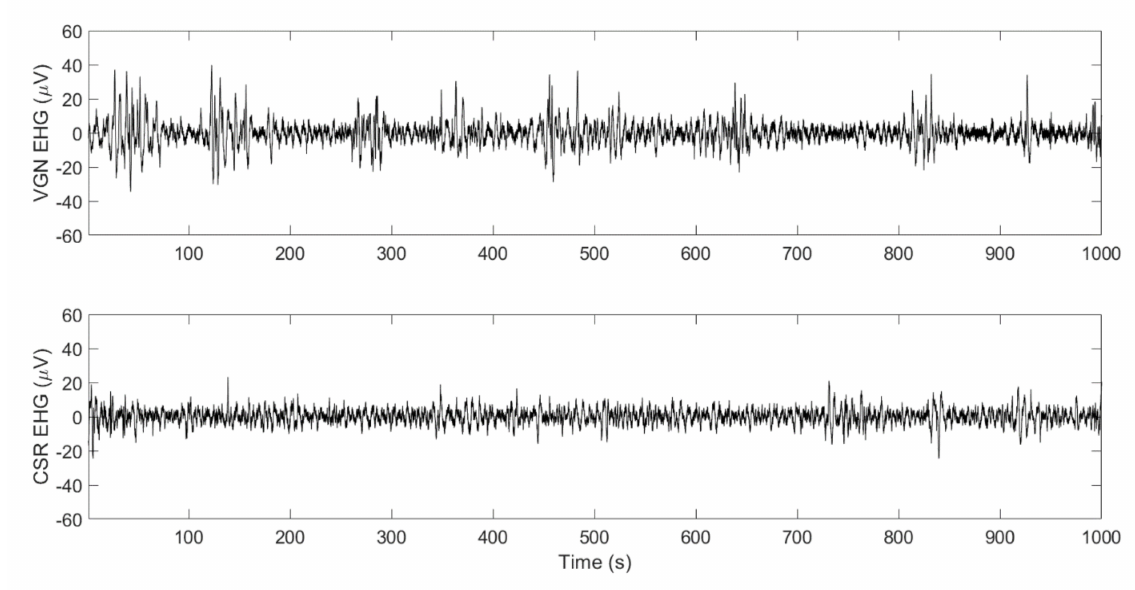
Figure 2. Example of postpartum electrohysterography (EHG) bipolar recordings from women who delivered vaginally (VGN, upper trace) and by cesarean section (CSR, lower